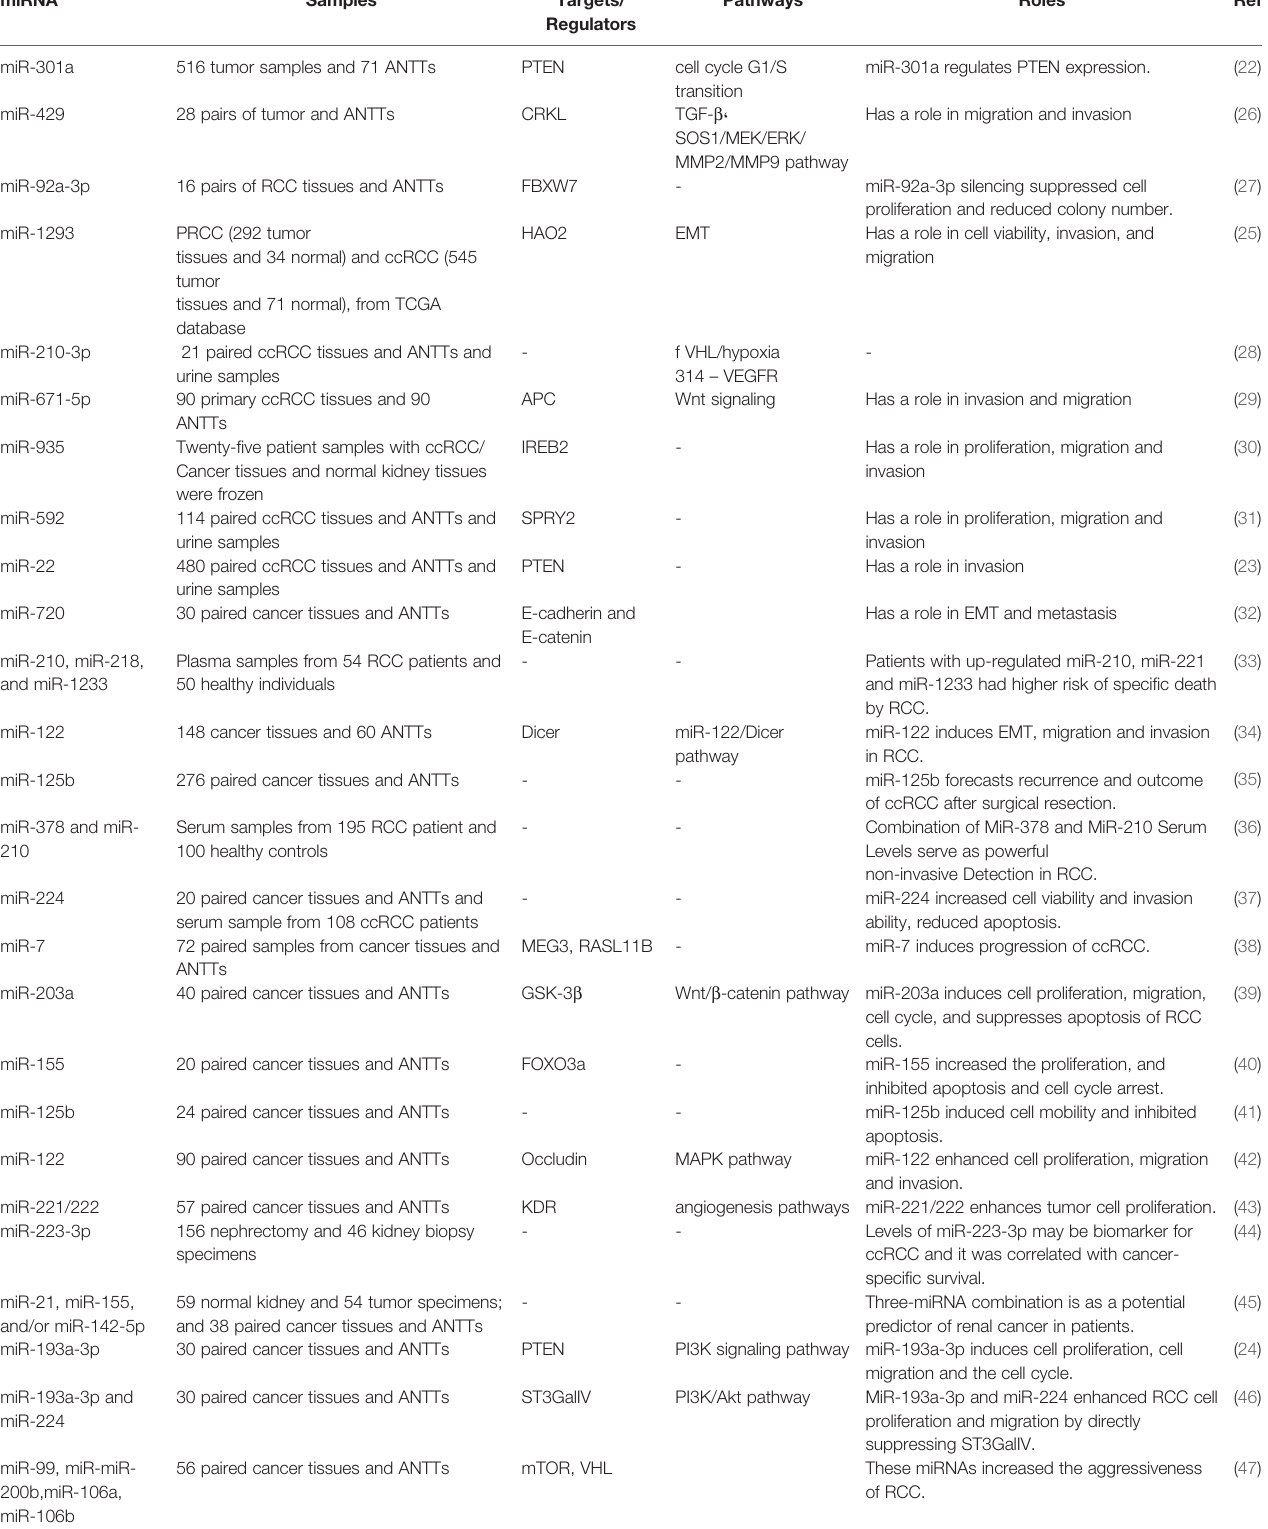
TABLE 1 | Up-regulated miRNAs in RCC (ANTTs: adjacent non-tumoral tissues).